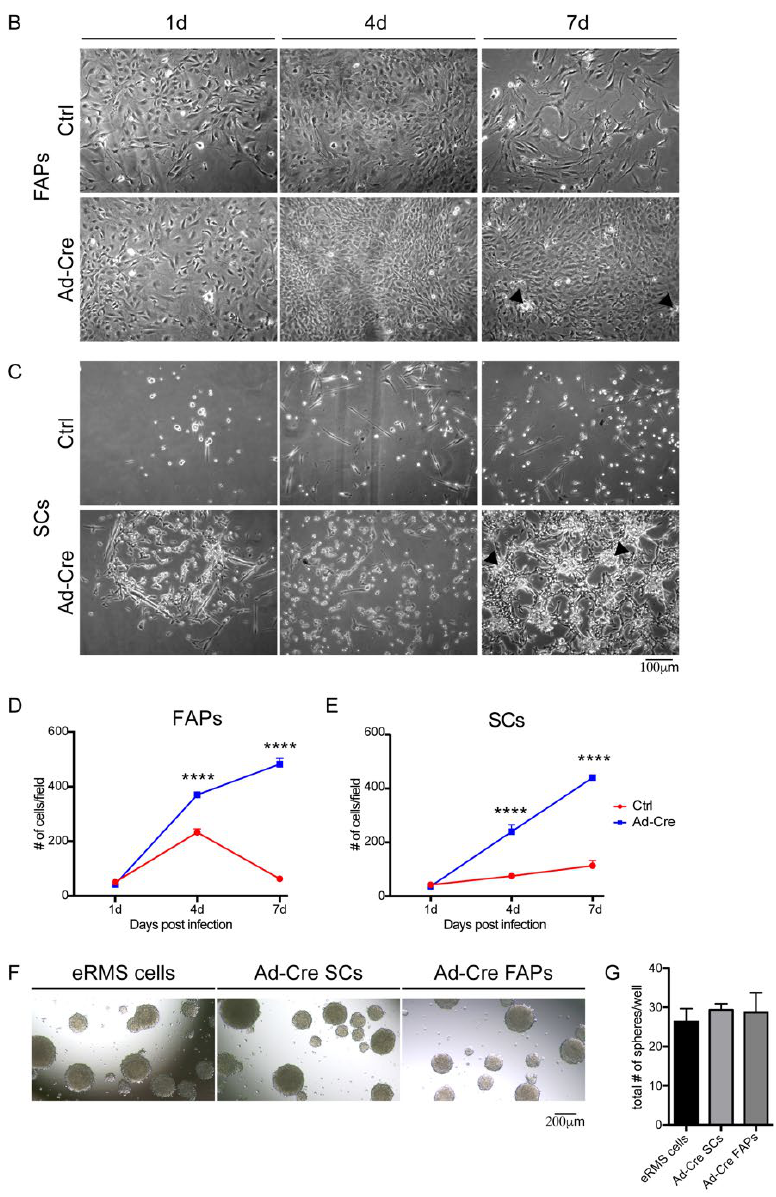
Figure 3. Analysis of the tumorigenic properties acquired by muscle-cell populations upon in vitro induction of genetic rearrangement by Ad-Cre infection. ( A ) Experimental workflow. FAPs and SCs magnetically sorted from LSL-Kras G12D/+ ; Tp53 Fl/Fl conditional mice were infected in vitro with Ad-Cre in order to induce the genetic rearrangements. ( B , C ) Representative images of Ad-Cre FAPs ( B ) and Ad-Cre SCs ( C ) together with Ctrl cells. Morphological changes between Ctrl and Ad-Cre cells were evaluated one, four and seven days (d) post-infection. Scale bar: 100 µm. ( D , E ) Growth curves of Ctrl and Ad-Cre FAPs ( D ) and Ad-Cre SCs ( E ). The total cell number (#) was defined by counting cellular bodies on brightfield images. The growth curves were derived from three independent biological replicates. Statistical analysis was performed by applying a two-way ANOVA test (**** p < 0.0001). ( F ) Rhabdo-sphere formation. Representative images of eRMS cells, Ad-Cre FAP- and Ad-Cre SC-generated spheres under low attachment conditions. Scale bar: 200 µm. ( G ) Quantification of rhabdo-sphere number. The number of the spheres generated by eRMS cells, Ad-Cre FAPs and Ad-Cre SCs was evaluated by counting the spheres present in each well of technical duplicates from three independent biological replicates.